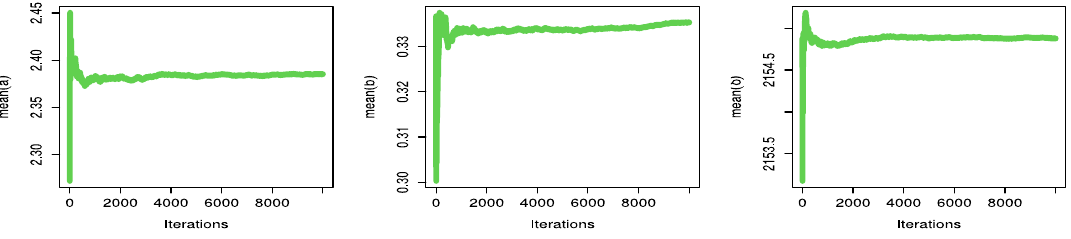
Figure 18. Convergence lines of MCMC results for Saudi Arabia data set.